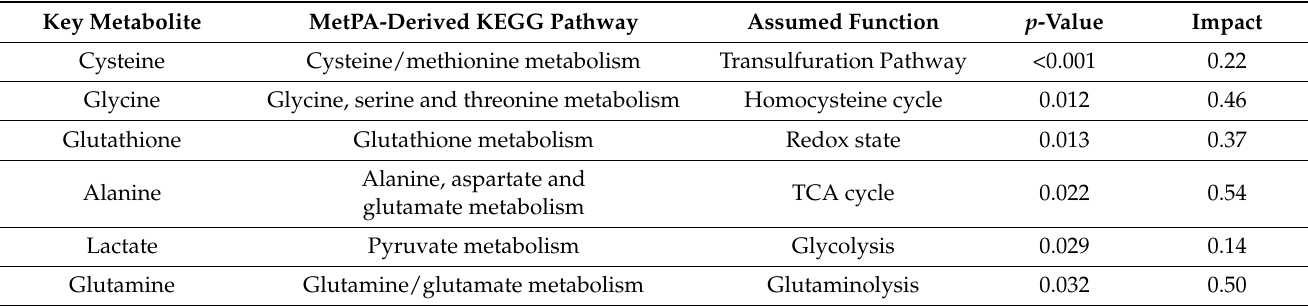
Table 2. “KEGG metabolite-based metabolic pathways” identified by the MetPA algorithm using 37 metabolites detected in the groups of indolent (A, B1 and AB thymomas) and aggressive (B2, B3 thymomas and thymic carcinomas, TC) groups of thymic epithelial tumors (TETs). The first column lists the “key metabolite” associated with each enriched metabolic pathway (columns 2). The assumed biological function associated with the given pathway is listed in column 3. p -values represent the dif- ferences in enrichment of the MetPA-derived “metabolite-based metabolic KEGG pathway” (column 2) between indolent and aggressive groups of TETs. “Impact” is a quantitative measure of the importance functional relevance of the individual metabolite in the respective pathway